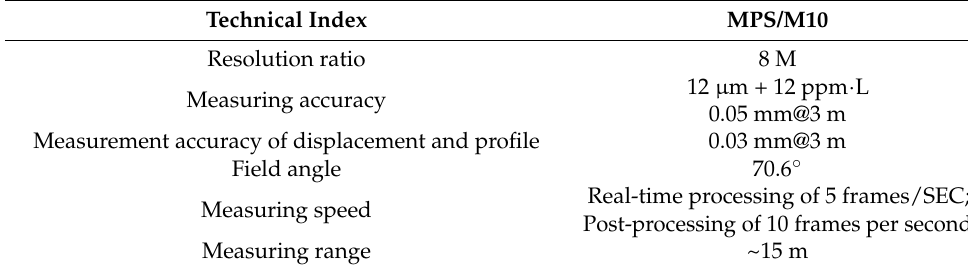
Table 2. MPS/M10 technical specifications.